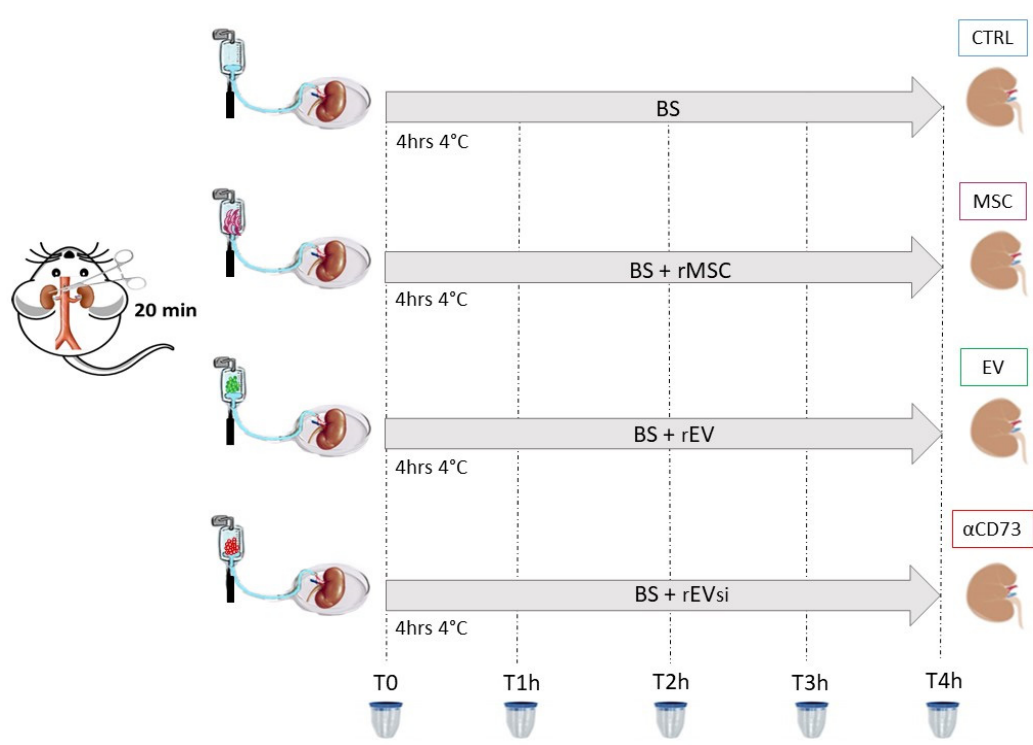
Figure 10. Ex vivo experimental design. Donation after circulatory death was simulated by clamping the rat aorta for 20 min. Then, the kidneys were perfused for 4 hours (“h”) with Belzer solution (BS) at 4 °C (CTRL group) or with BS supplemented with 3 × 10 6 rat mesenchymal stromal cells (rMSCs; MSC group) or extracellular vesicles (rEVs) isolated from 3 × 10 6 rMSCs (EV group) or from 3 × 10 6 CD73-silenced rMSCs (rEVsi; α CD73 group). During the perfusion, the effluents were collected every hour. T0 indicates the start of hypothermic perfusion, and T1h, T2h, T3h, and T4h indicate 1, 2, 3, and 4 h after the start of hypothermic perfusion. The renal tissue was collected at the end of the perfusion.